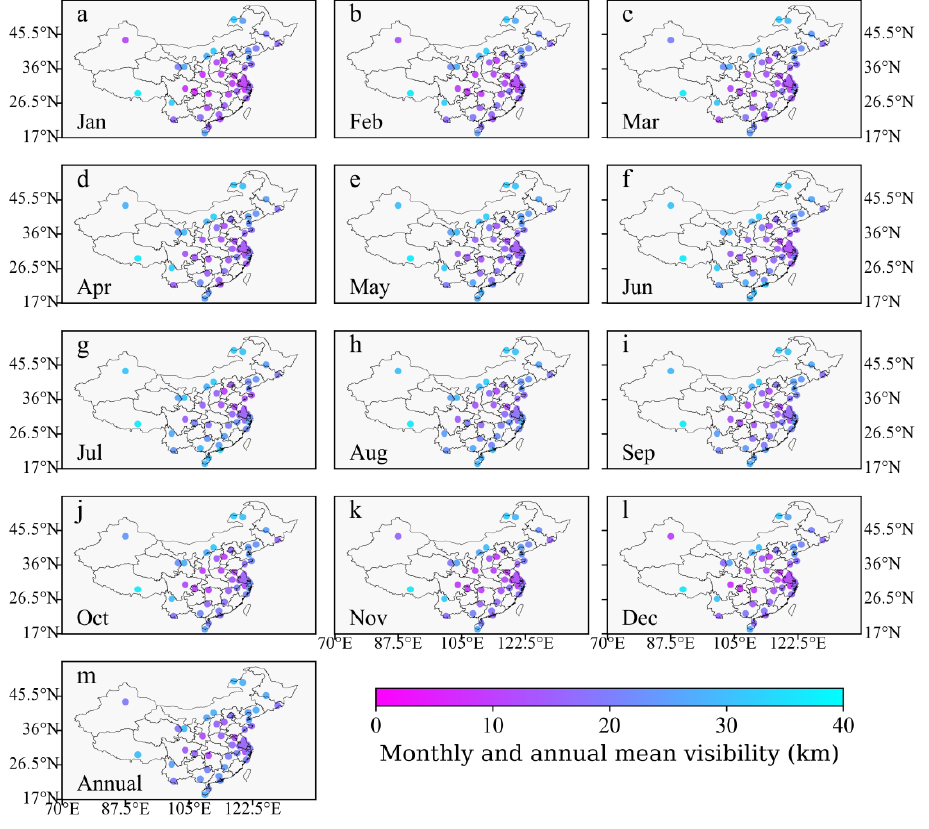
Figure 3. Spatial distributions of monthly and annual visibility during 2010–2020. The visibility of airports in eastern and central China is at a poor level all year round, and LXA has good visibility all year round. Airports in south and northwest China have better visibility from May to October and poorer visibility from November to April. In winter and spring, airports show poor visibility. On the contrary, good visibility appears in summer and autumn. URC at the northwest corner of China best show the above monthly visibility law. Annual mean visibility during 2010–2010 ranges from 9.8 km at HGH in Hangzhou to 37.7 km at LXA (Figure 3). The spatiotemporal distribution of annual visibility is quite similar to those of monthly visibility. The good visibilities appear in the north, south and west China, and the central and east China give poor visibility. The trends of monthly visibility, ranging from –2.58 km/y at URC in Urumqi in February to 2.31 km/y at JNZ in Jinzhou in July, display different distribution from monthly means spatiotemporally (Figure